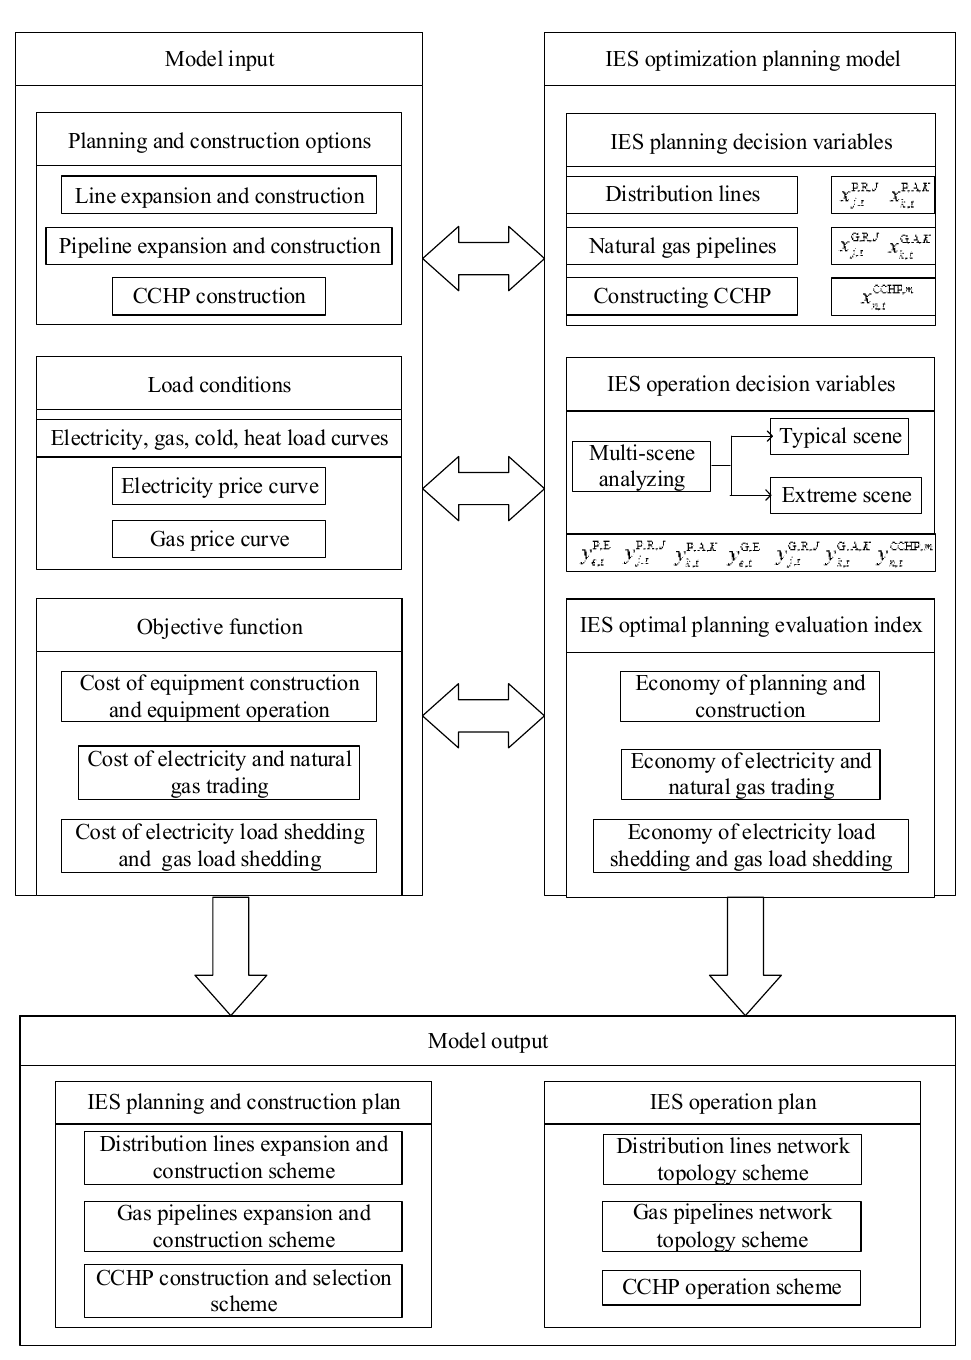
Figure 3. IES optimization planning model.